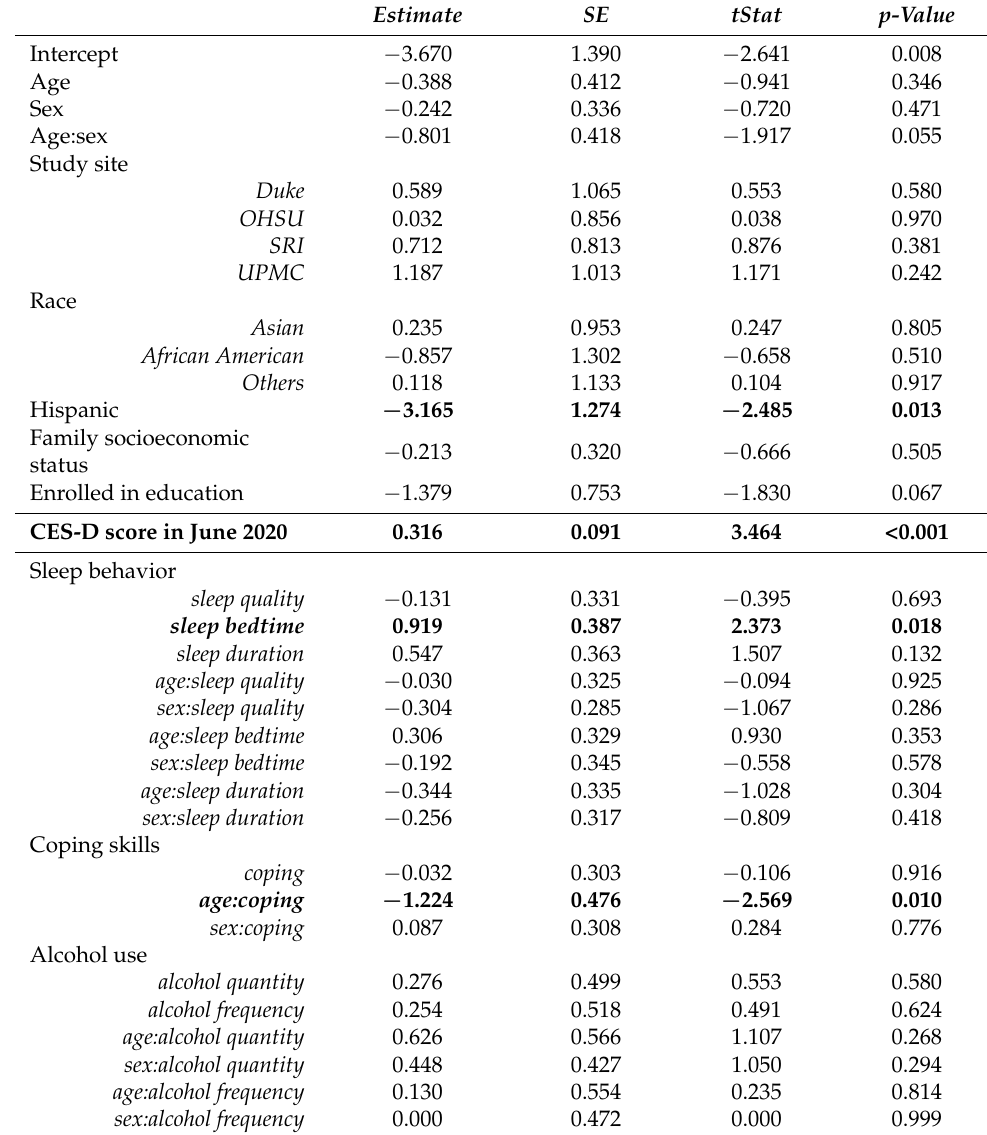
Table 3. Results of the complete logistic regression model applied to the 119 participants who exceeded the depression threshold in June 2020. Significant predictors are highlighted in bold ( p <